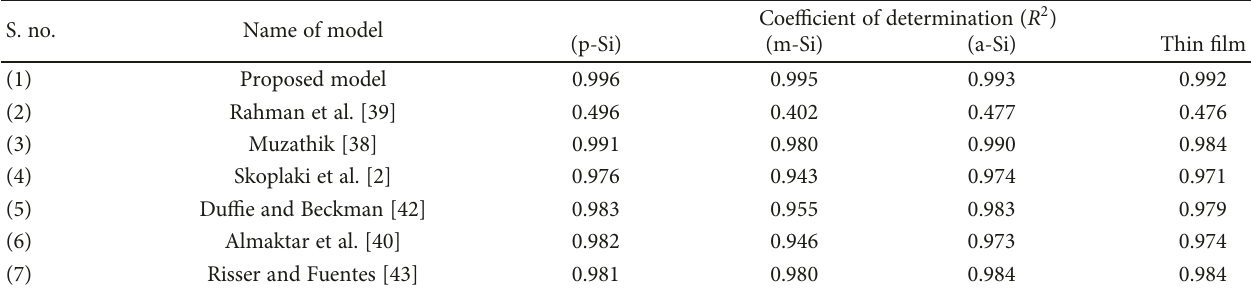
Table 9: Coe ffi cient of determination ( R 2 ) of each PV module in